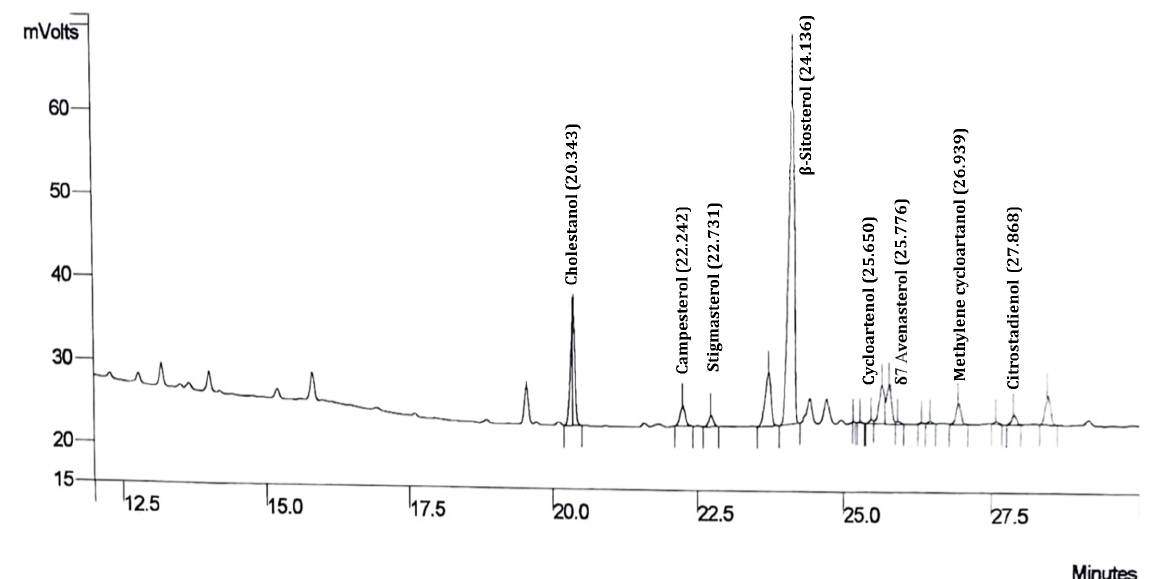
Figure 3. Chromatogram of Phytosterols from Atlas Pistachio Seeds.